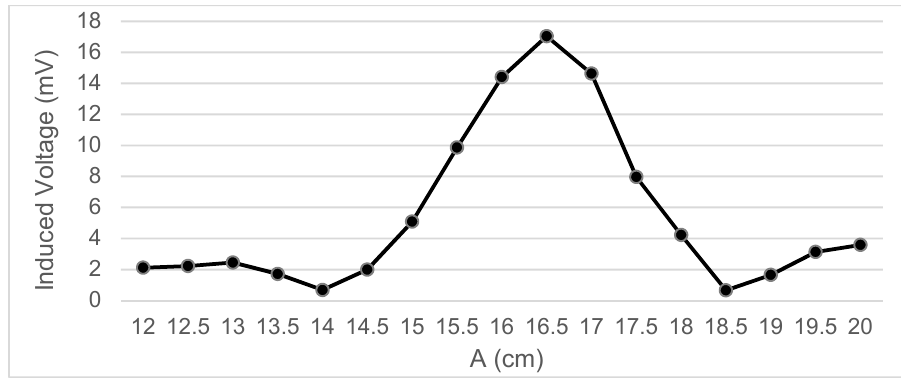
Figure 4. Data representation for B = 16 cm, C = 5.5 cm; Test 4.1.